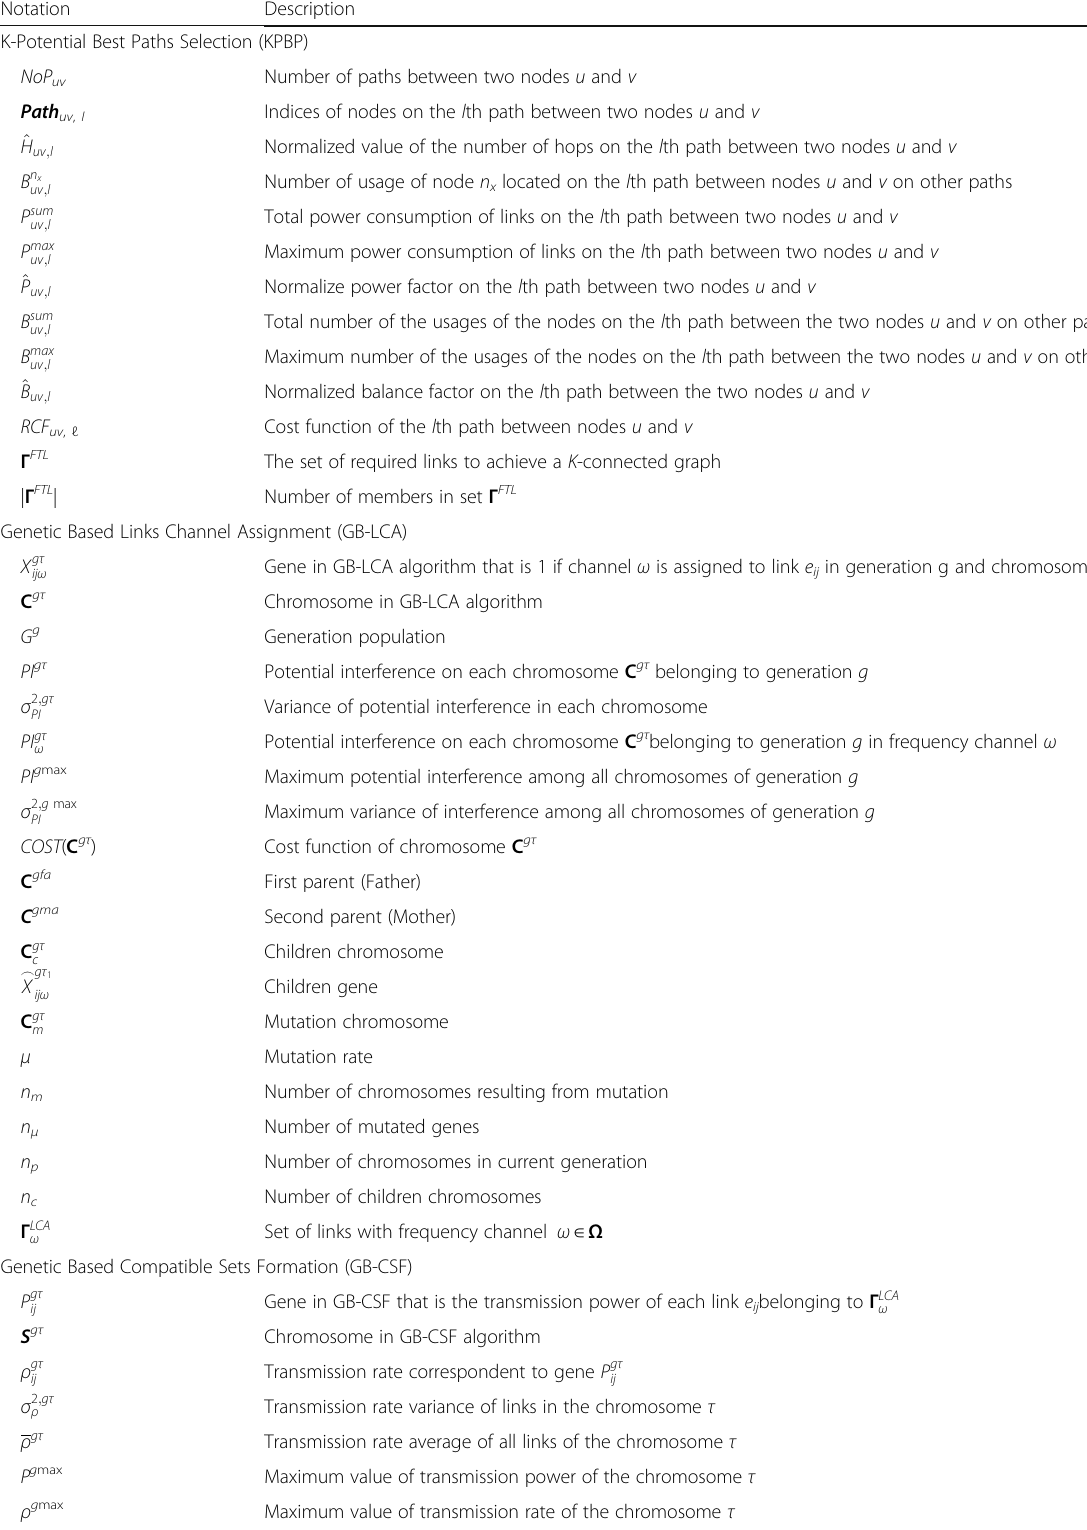
Table 2 List of notations used in